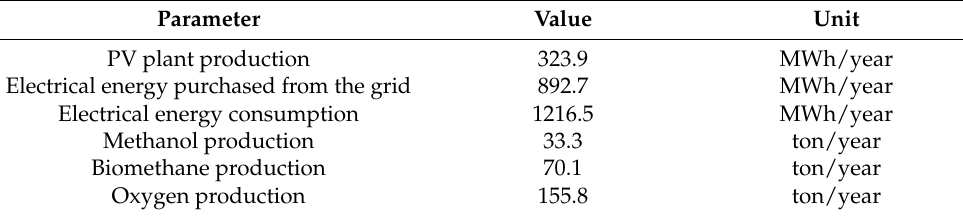
Table 4. Summary of thermodynamic results: annual mass and energy balance.